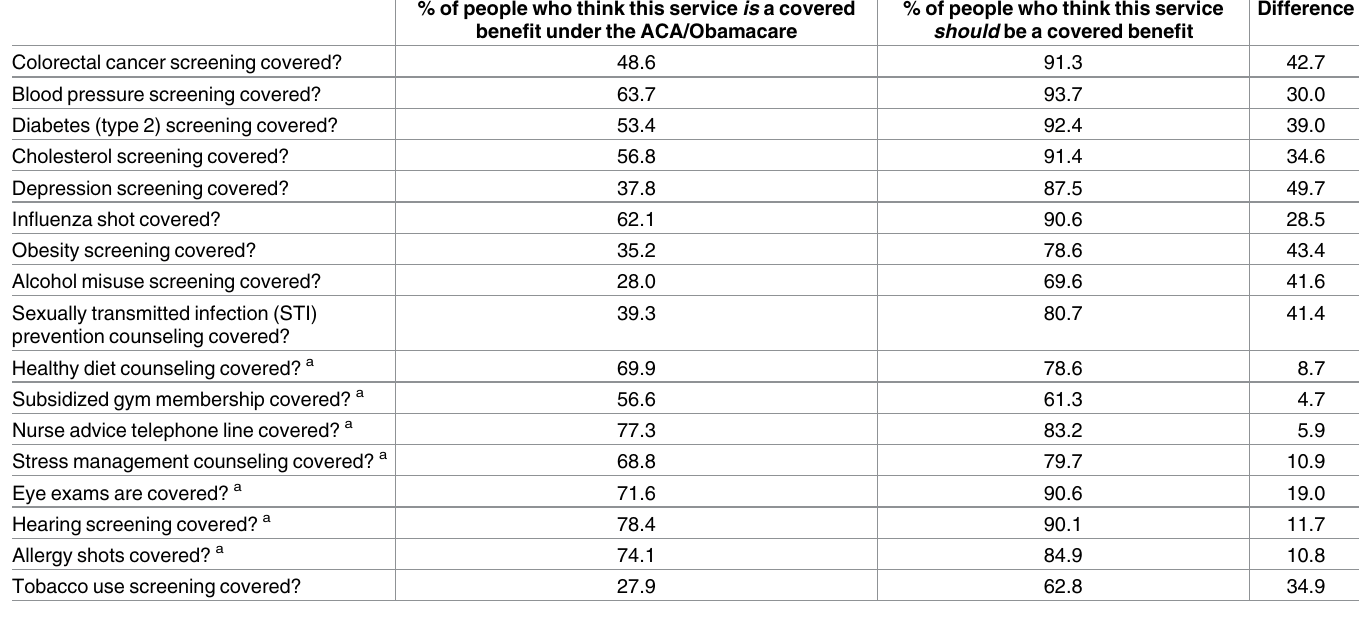
Table 3. Comparing the percent of people who think servicesare coveredby the ACA with the percent of people who think servicesshould be covered. % of people who think this service is a covered % of people who think this service benefit under the ACA/Obamacare should be a covered